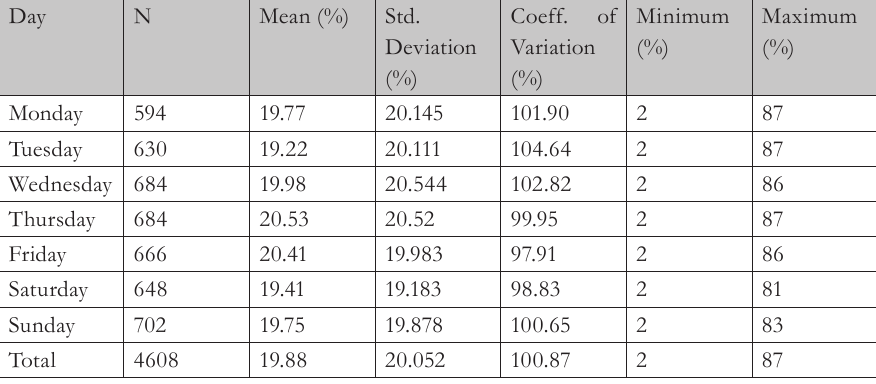
Tab. A – Proportion of return transportations offered from all analysed countries to Slovakia depending on the specific day of the week in (%). Source: own